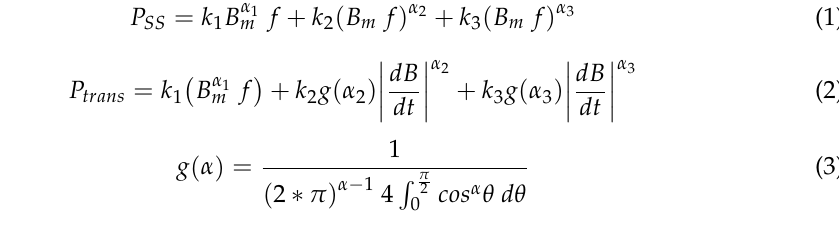
Figure 25. Torque speed characteristics of the designed motor with optimized turn-on and turn-off angles.